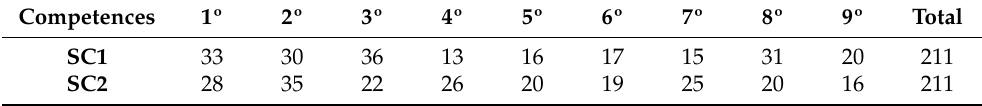
Table 4. Result of the voting process for the students in relation to the importance of the